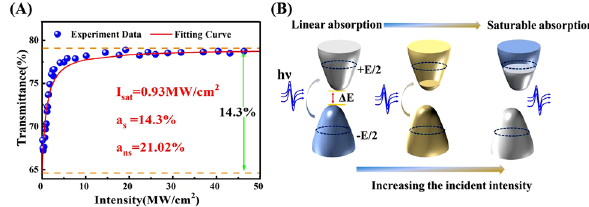
Figure 3: Saturable absorption properties of SA. (A) Nonlinear saturable absorption curve. (B) Three stages of the SA